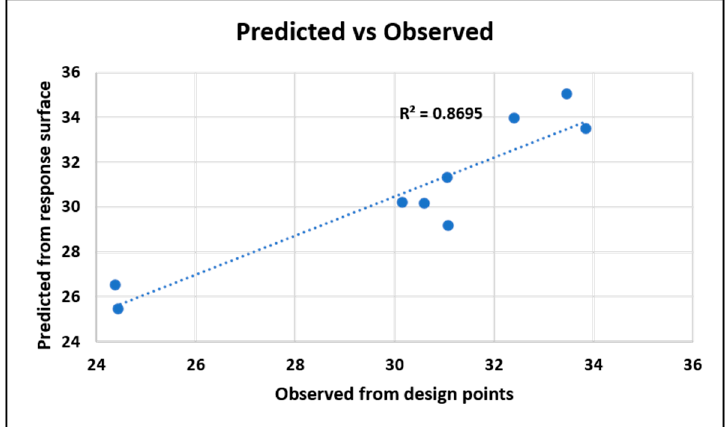
Figure 19. Goodness of fit for the original system from the dielectric response.